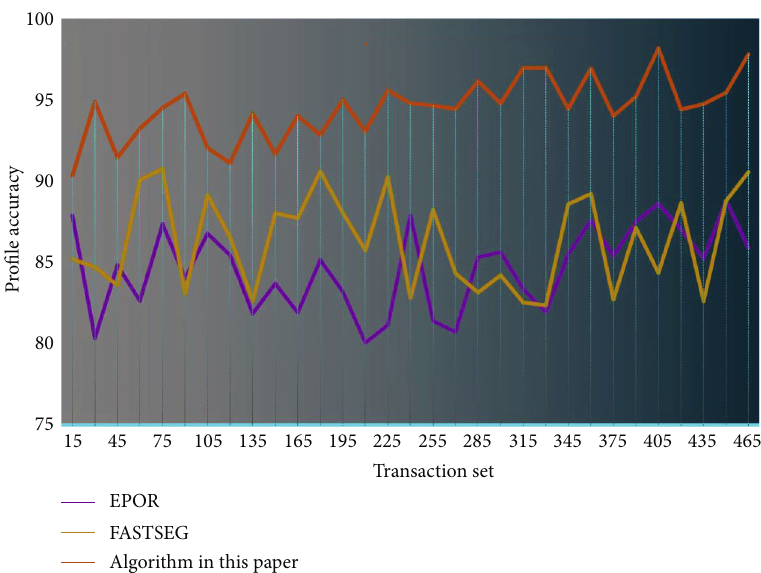
Figure 7: Experimental results of contour accuracy.